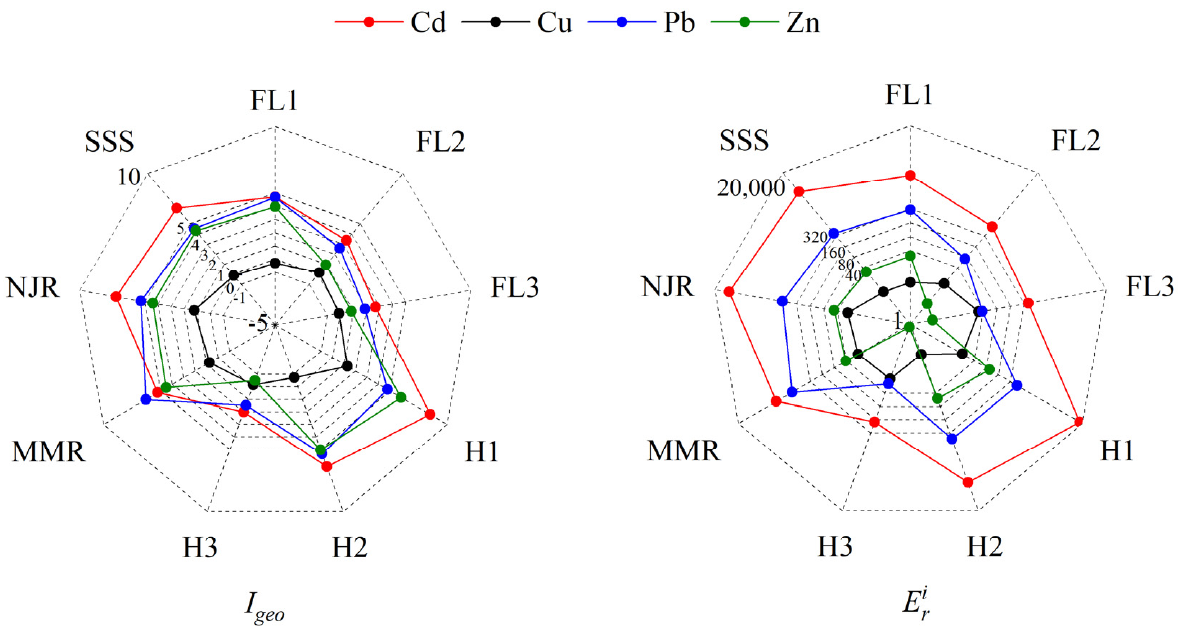
Figure 5. I geo and E ri of heavy metals.